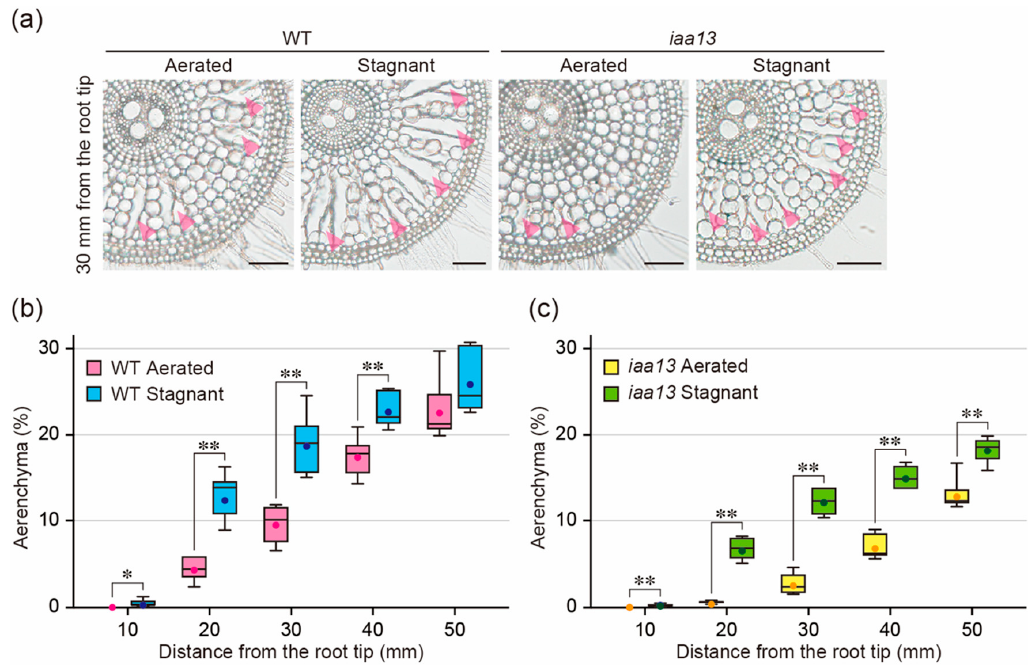
Figure 1. Aerenchyma formation under aerated or stagnant conditions. ( a ) Cross-sections at 30 mm from the tips of adventitious roots of the wild-type (WT) and iaa13 mutant. Aerenchyma is indicated by magenta arrowheads. Bars = 100 μ m. ( b and c ) Percentages of aerenchyma in root cross-sectional area at 10, 20, 30, 40, and 50 mm. Twenty-day-old aerobically grown WT ( b ) and iaa13 ( c ) seedlings were further grown under aerated or stagnant conditions for 48 h. ( b and c ) Significant differences between the conditions at p < 0.01 are denoted by ** (two-sample t -test). Boxplots show the median (horizontal lines), 25th to 75th percentiles (edges of the boxes), minimum to maximum (edges of the whiskers), and mean values (dots in the boxes) ( n = 6).